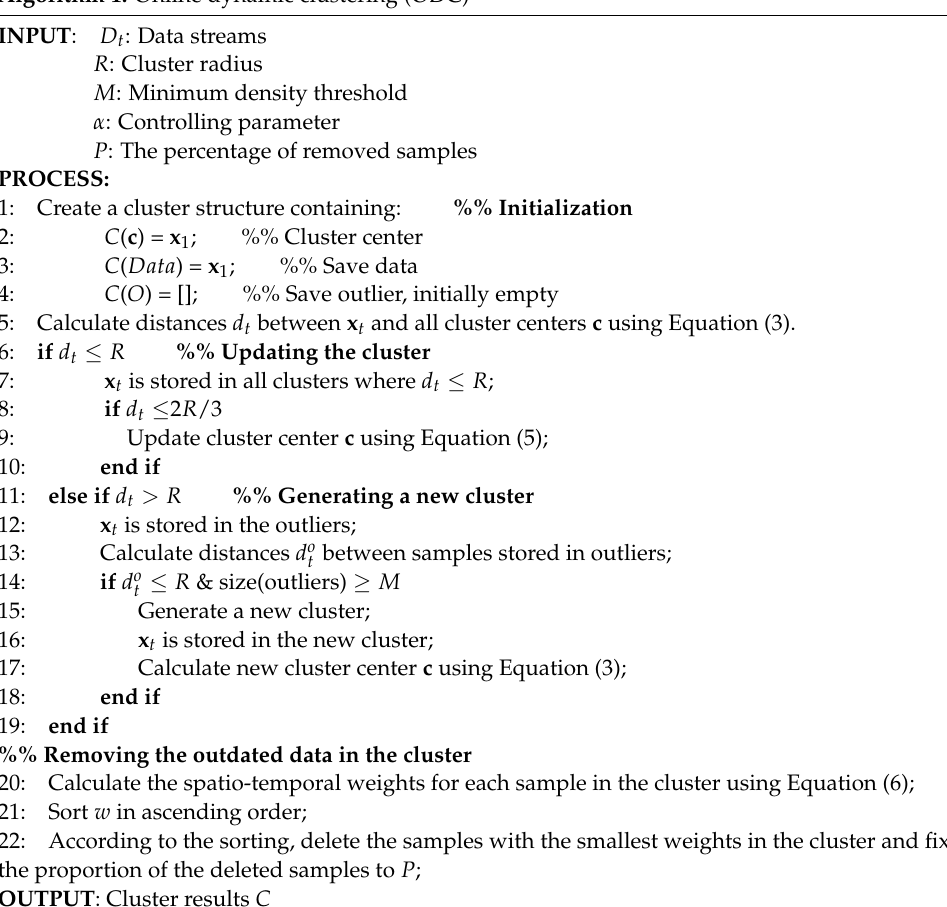
Algorithm 1: Online dynamic clustering